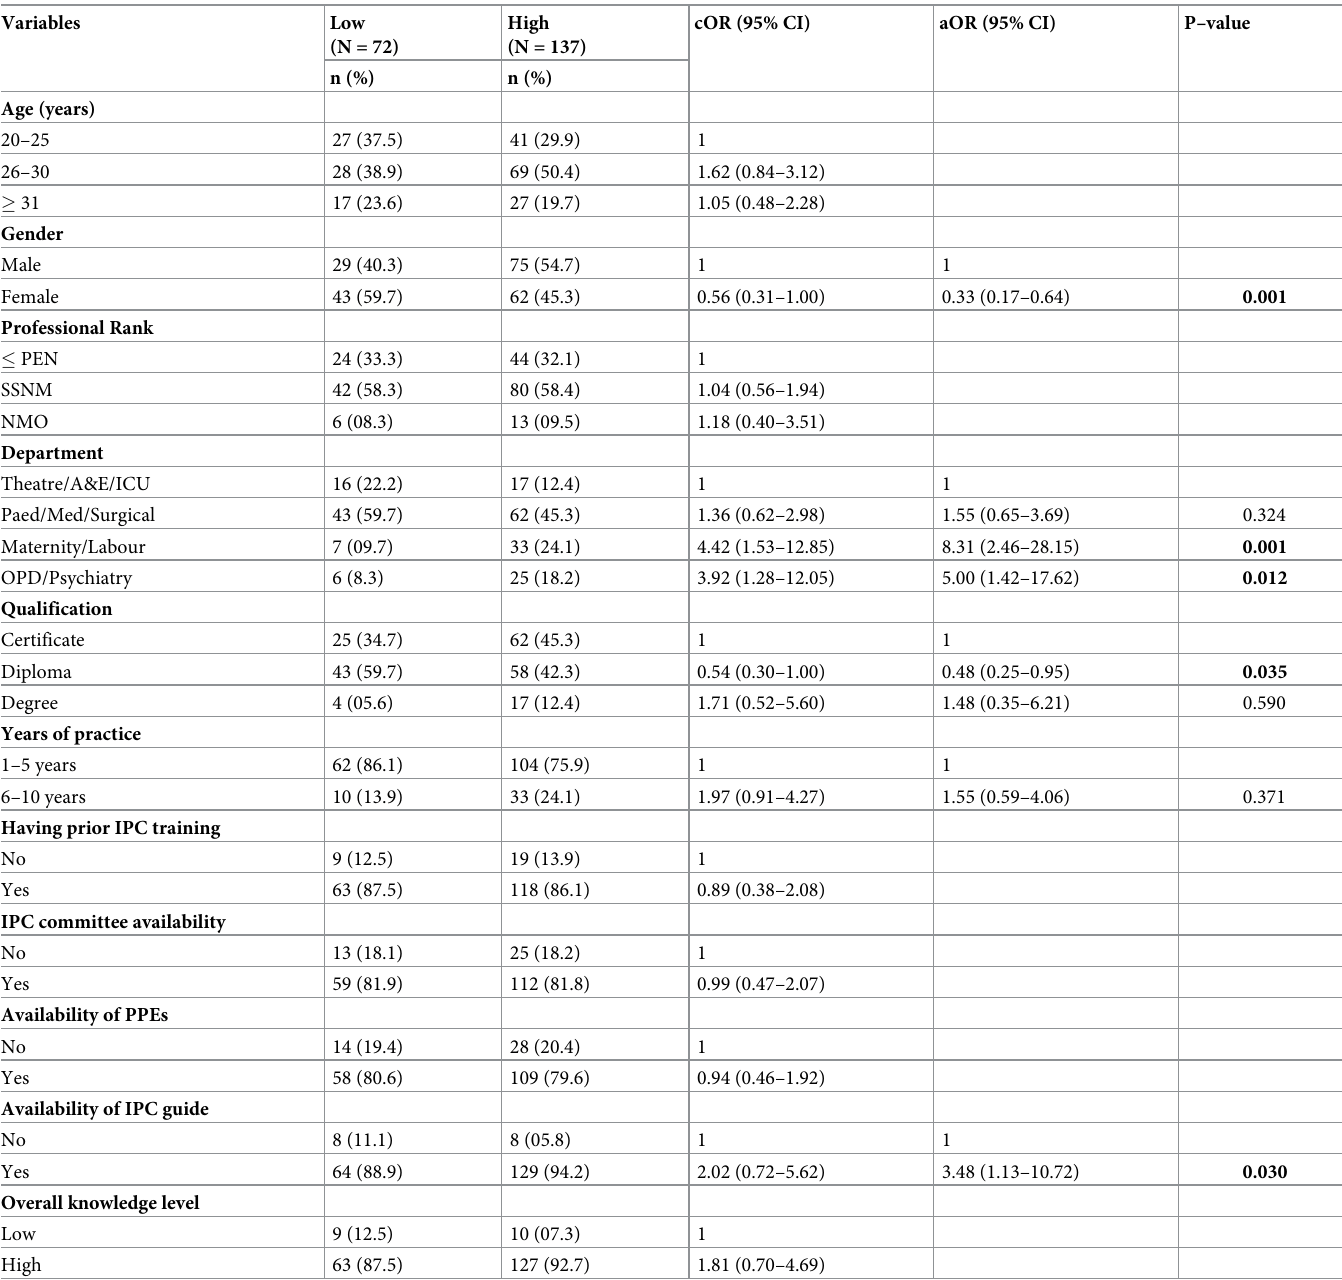
Table 5. Determinants of IPC compliance (n =